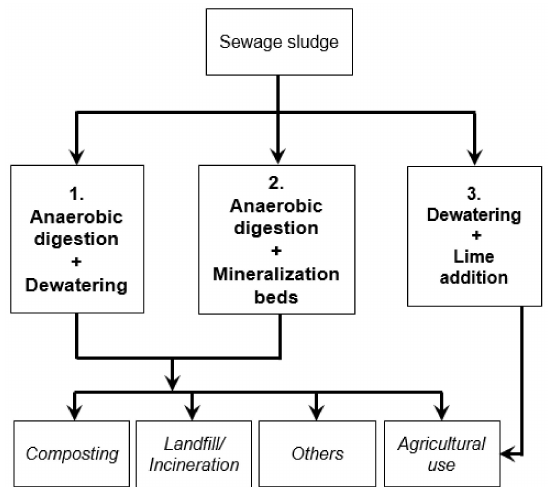
Figure 4. Common sludge management in Sweden (adapted from [33]). “Others” stands for land restoration and construction land. The treatment methods are in bold, while disposal methods in